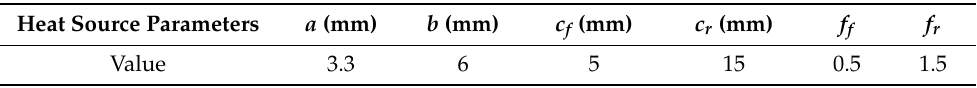
Table 3. Heat source